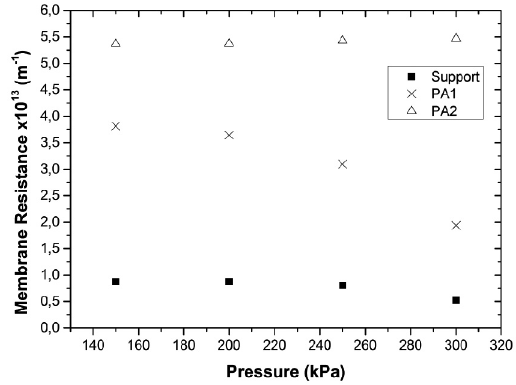
Figure 5. Membranes resistance analysis by